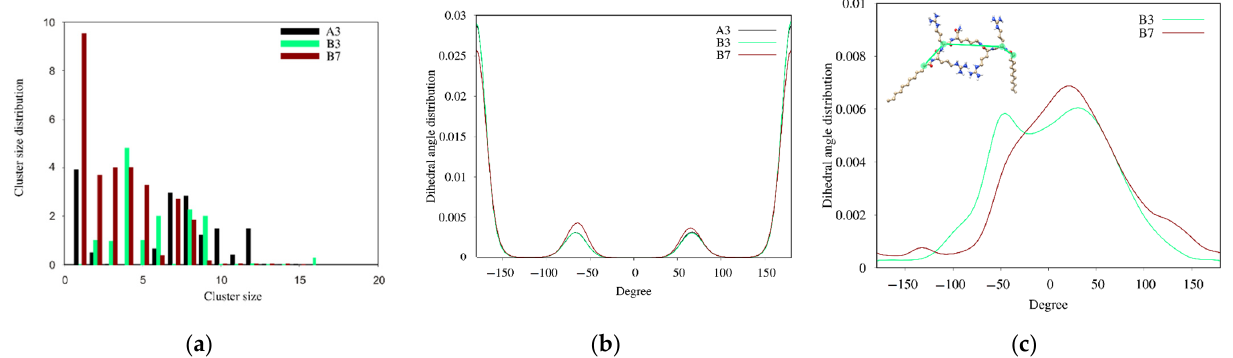
Figure 14. ( a ) Cluster size distribution over the last 50 ns of MD simulations. ( b ) Dihedral angle distribution for all C-C bonds of the hydrocarbon fatty acid tails. ( c ) Dihedral angle distribution of the dihedral angle between the carbon atom of the first methylene group of the N-terminal fatty acid, the alpha carbon of the N-terminal arginine, the alpha carbon of the C-terminal arginine, and the carbon atom of the first methylene group of the C-terminal fatty acid (C2 N-terminal acyl chain —C α N-terminal Arg —C α C-terminal Arg —C2 C-terminal acyl chain ).